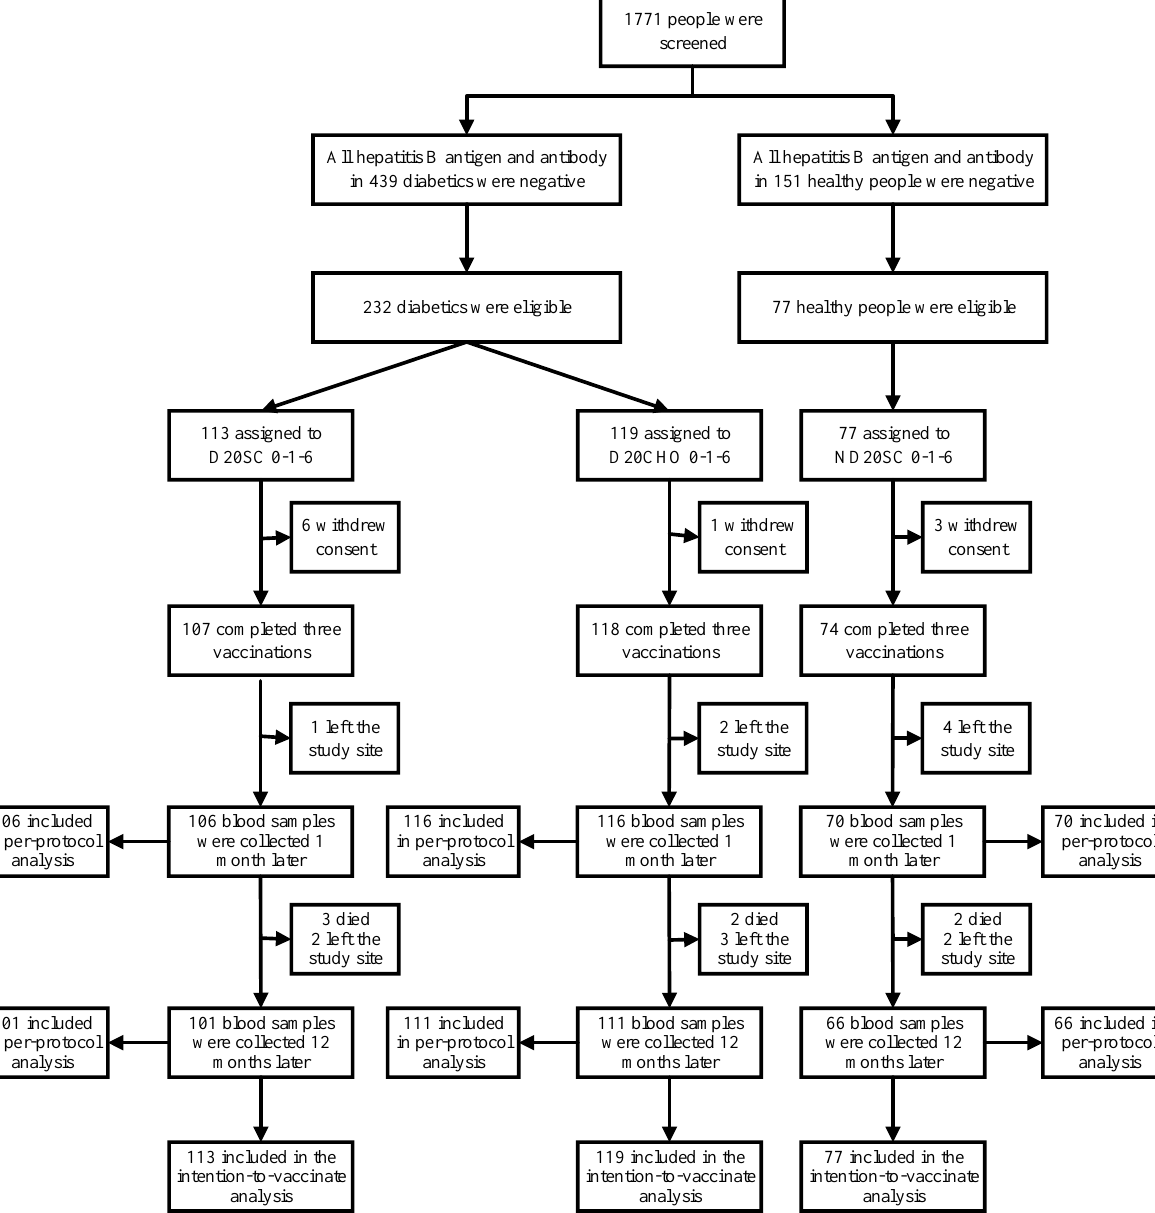
Figure 1. Participant flowchart in hepatitis B vaccine trial investigating the 12-month persistence of immunity in diabetic patients and healthy controls.